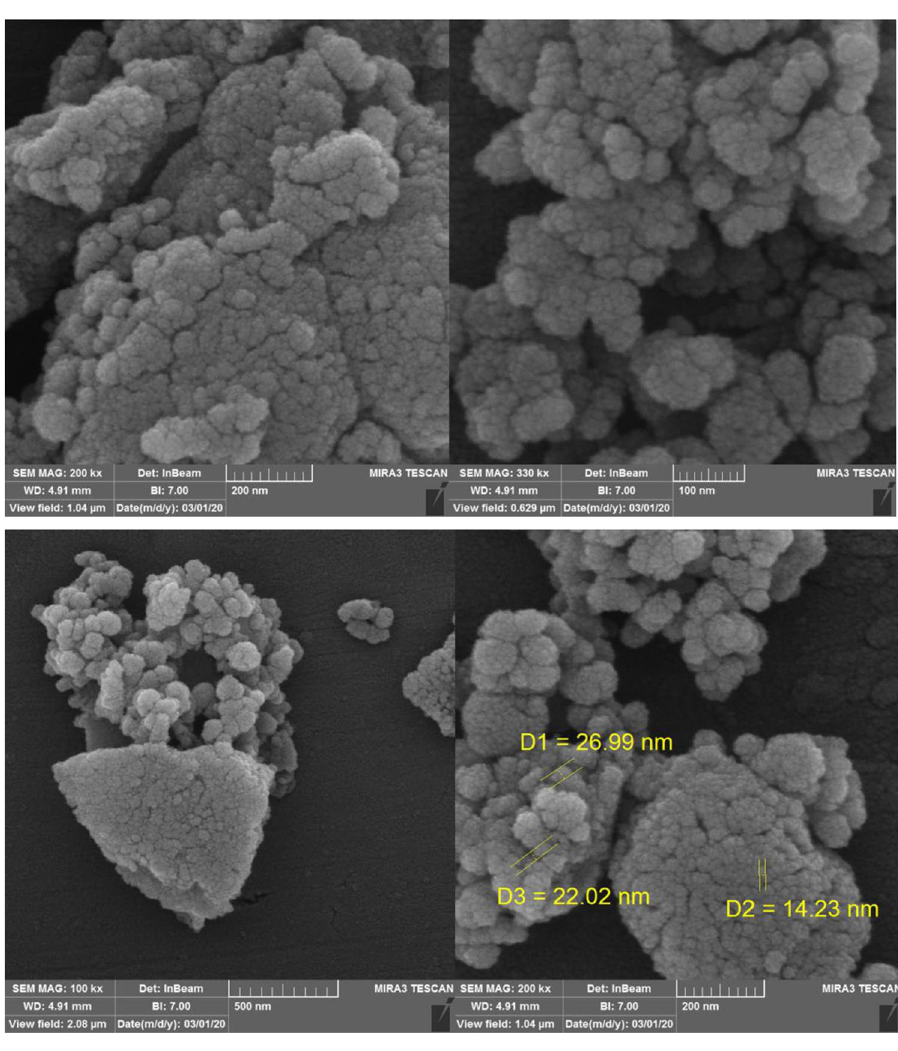
Figure 6. SEM images of